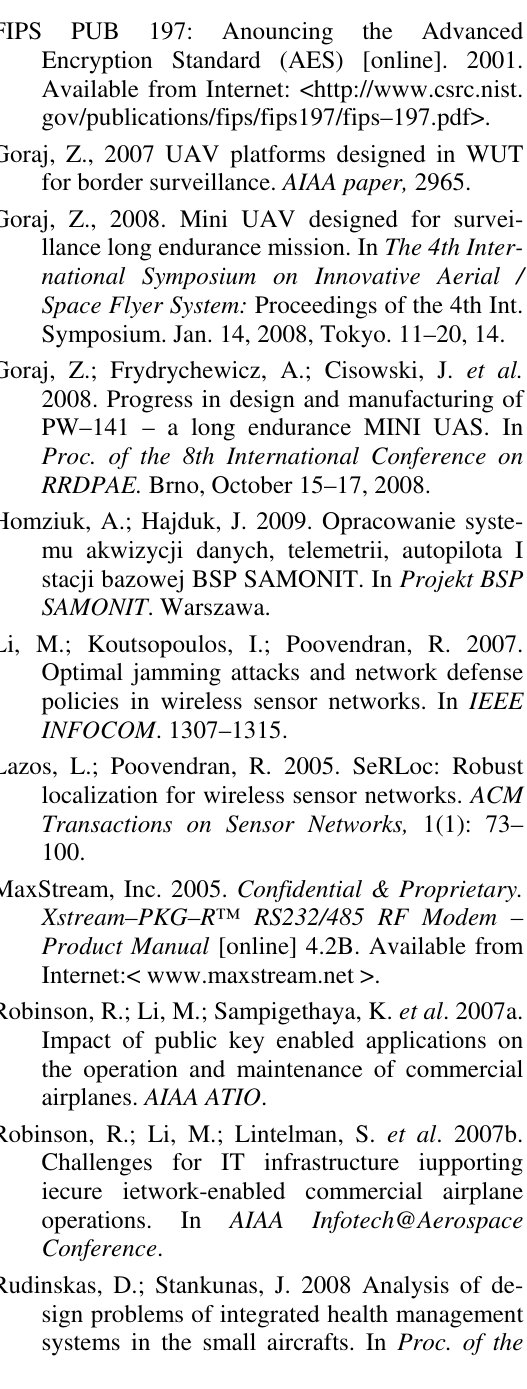
Fig 5. Plain text message and AES128 encrypted message (Homziuk et al.